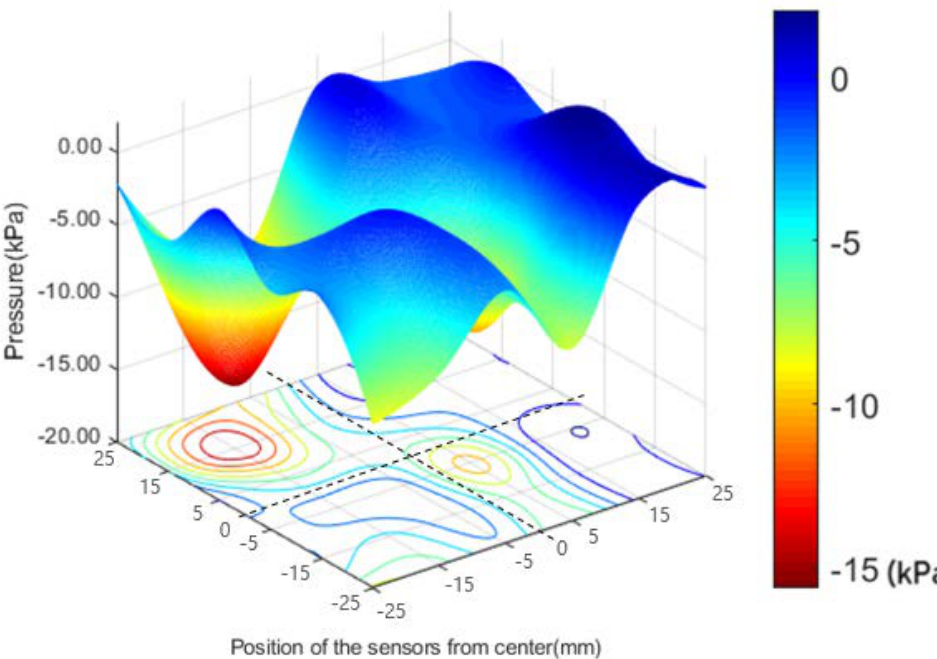
Figure 28. 3D Plot for Discrepancy in Peak Pressure (the 2 nd Case Pressure - Wet Average, SWAY).